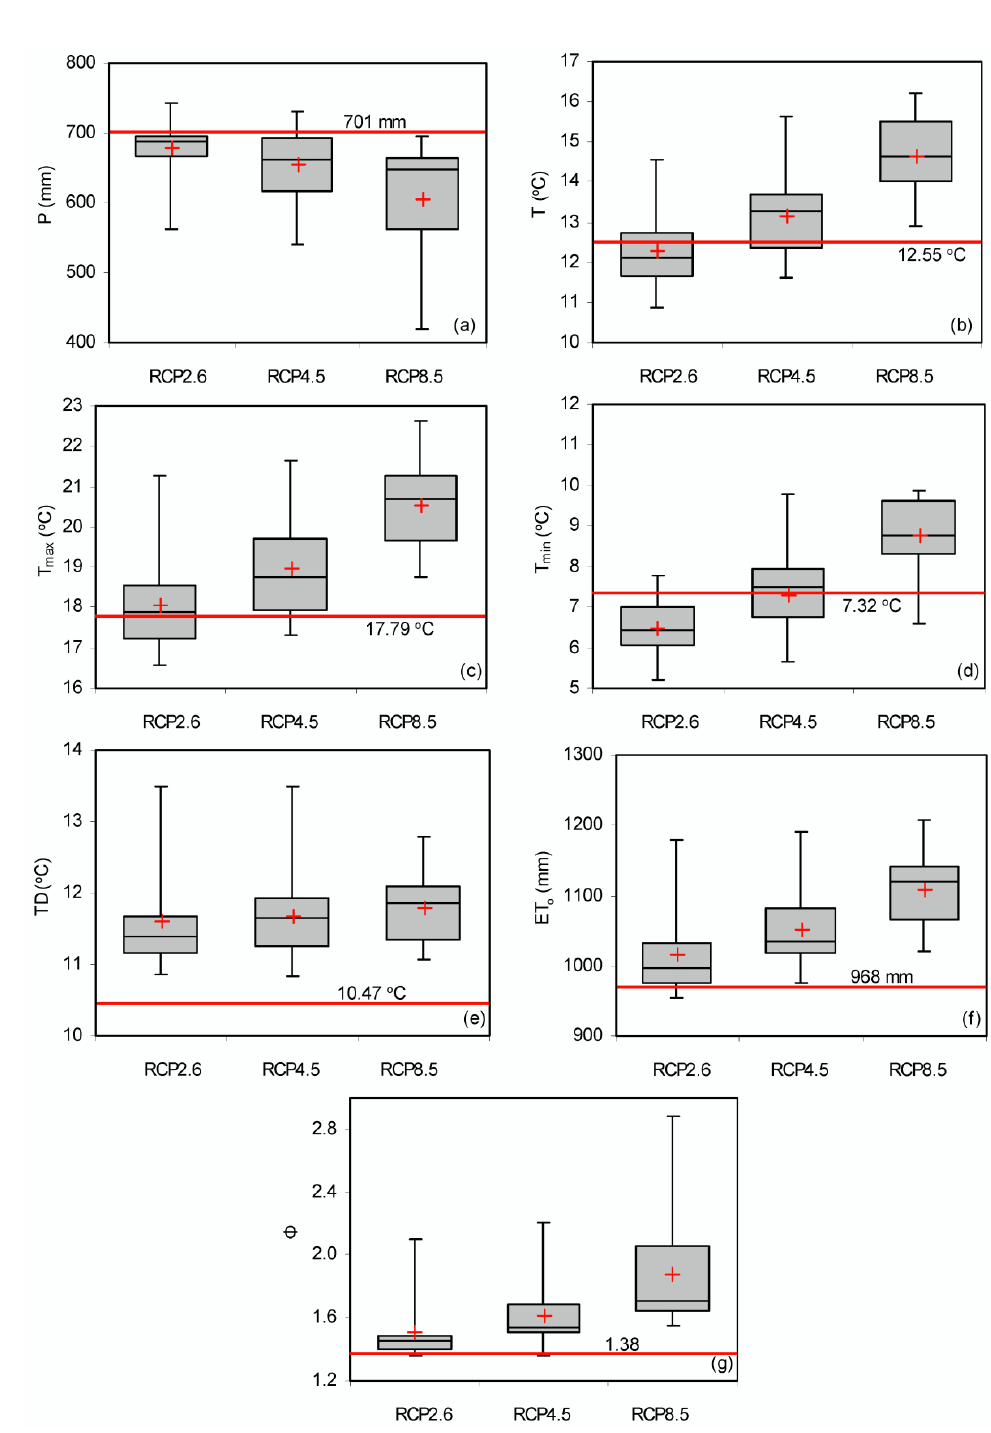
Figure 5. Box-whisker plots for the mean annual values of ( a ) precipitation P (mm), ( b ) temperature T ( ◦ C), ( c ) maximum temperature T max ( ◦ C), ( d ) minimum temperature T min ( ◦ C), ( e ) di ff erence between maximum and minimum temperature TD ( ◦ C), ( f ) reference crop evapotranspiration ET o (mm) and ( g ) Φ = ET o / P of GCMs for each climate change scenario (RCP2.6, RCP4.5, RCP8.5). The red lines correspond to the mean annual values of the period 1/5/2012 – 31/4/2018.